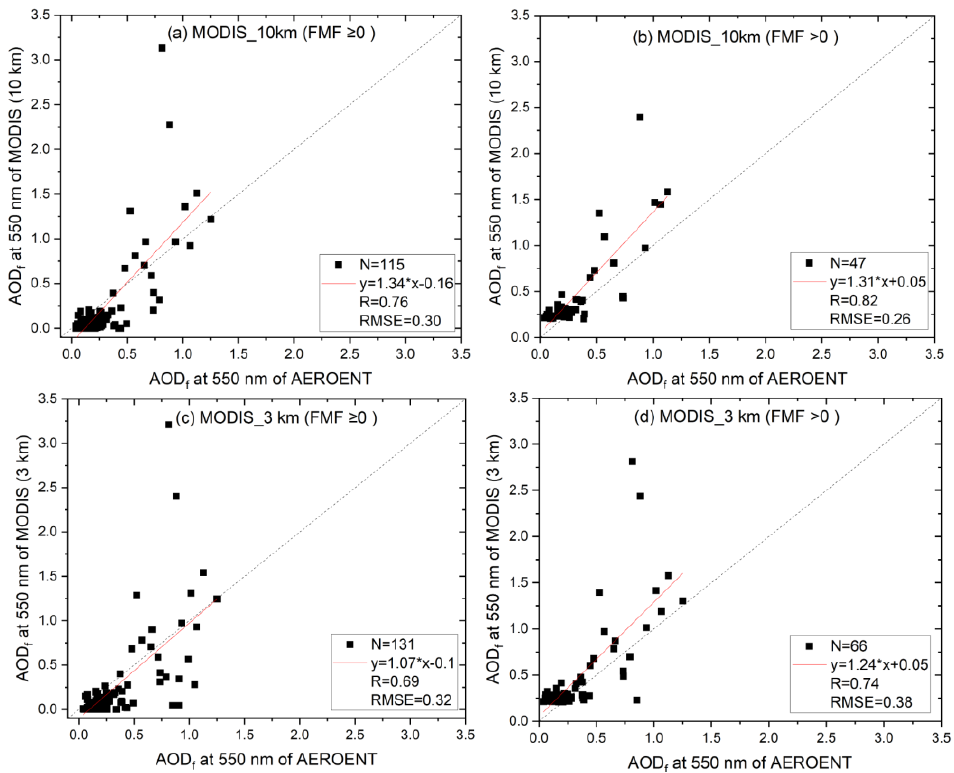
Figure 4. Validation of MODIS AOD f products at 550 nm against two typical sites AERONET measurements for a year. (a) and (c) are the AOD f at 550 nm when FMF ≥ 0, (b) and (d) are the AOD f when FMF >0.